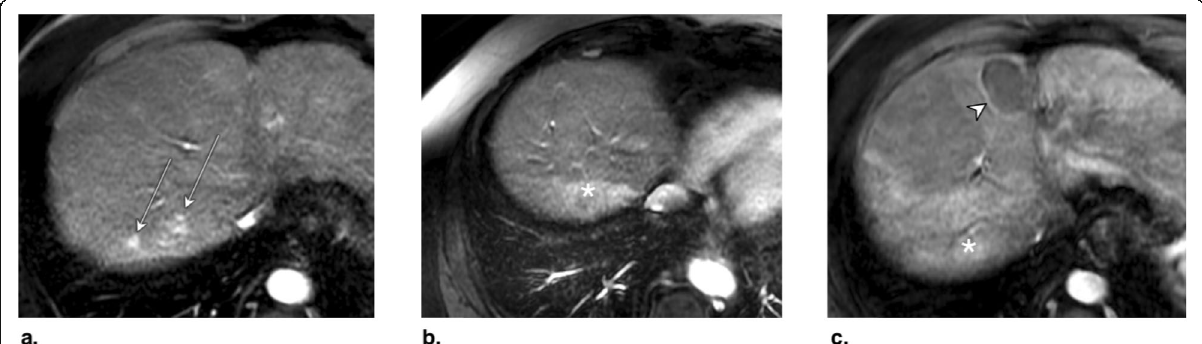
Fig. 24 Axial T1-weighted MR in late arterial phase obtained ( a ) pretreatment: image shows two LR-4 observations (arrows) with nonrim arterial phase hyperenhancement (APHE). b 2 months post drug-eluting beads TACE (DEB-TACE): image shows regional APHE (asterisk). c 10 months post DEB-TACE: image shows decrease in regional APHE (asterisk). No nodular enhancement nor washout is visible. The treated observation is categorized LR-TR nonviable. Note the radiofrequency ablation cavity of another treated lesion